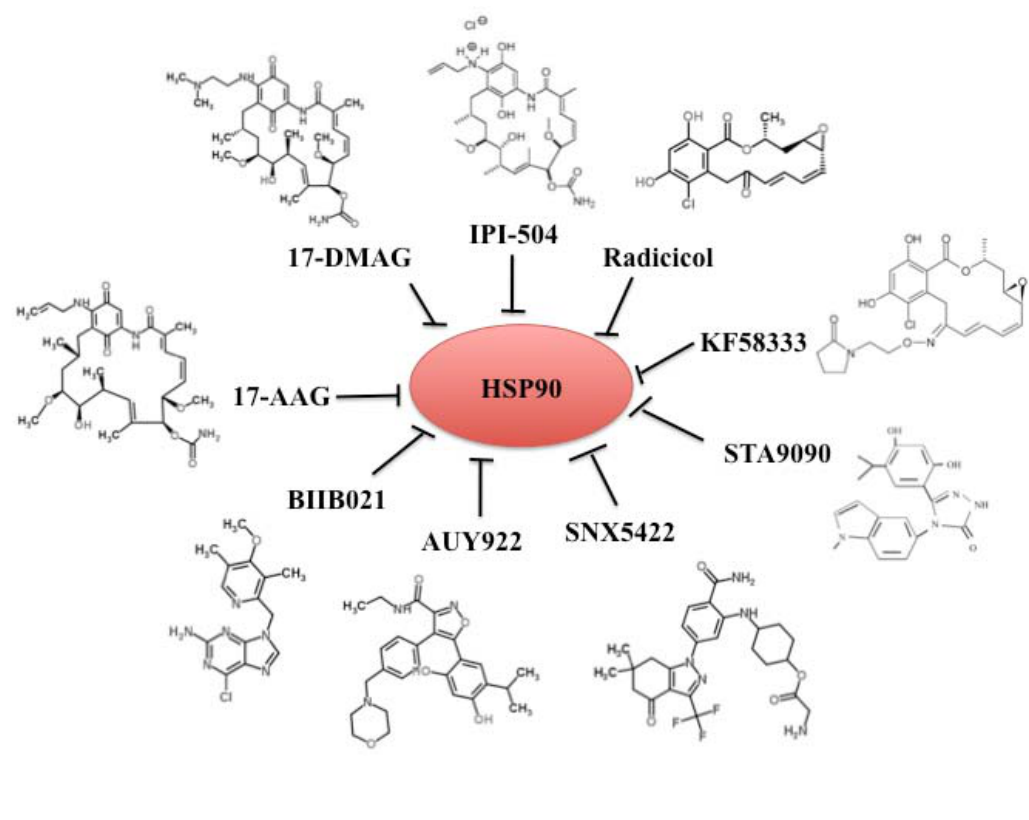
Figure 2. Hsp90 inhibitors. Hsp90 inhibitors are classified into three groups: benzoquinone ansamycins 17-AAG and its derivatives 17-DMAG and IPI-504, radicicol and its derivates, and small synthetic